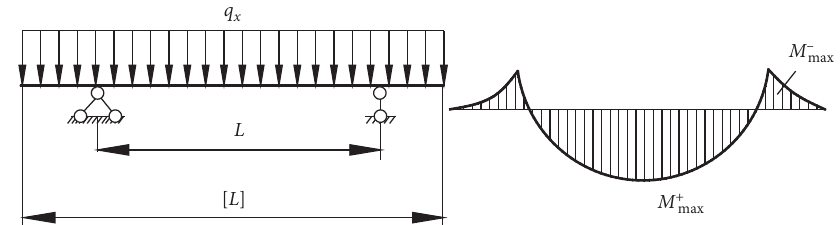
Figure 6: Bending moment.